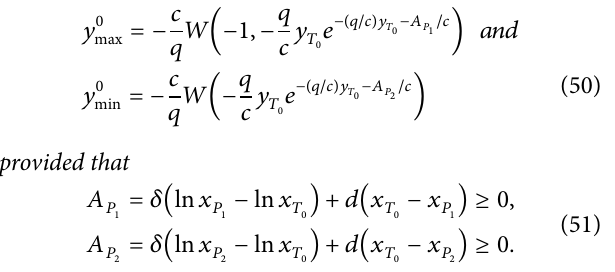
, (b) (퐴푇/훼) ≤ (훿/푑) (훿/푑) < (퐴푇/훼) at point 푇 0 = ( 푥 푇 0 , 푦 푇 0 ) Γ 𝐼𝑐